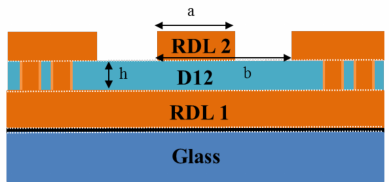
Figure 15. TDR measurement results. ( a ) For 80 μm pad width. ( b ) For 50 μm pad width.